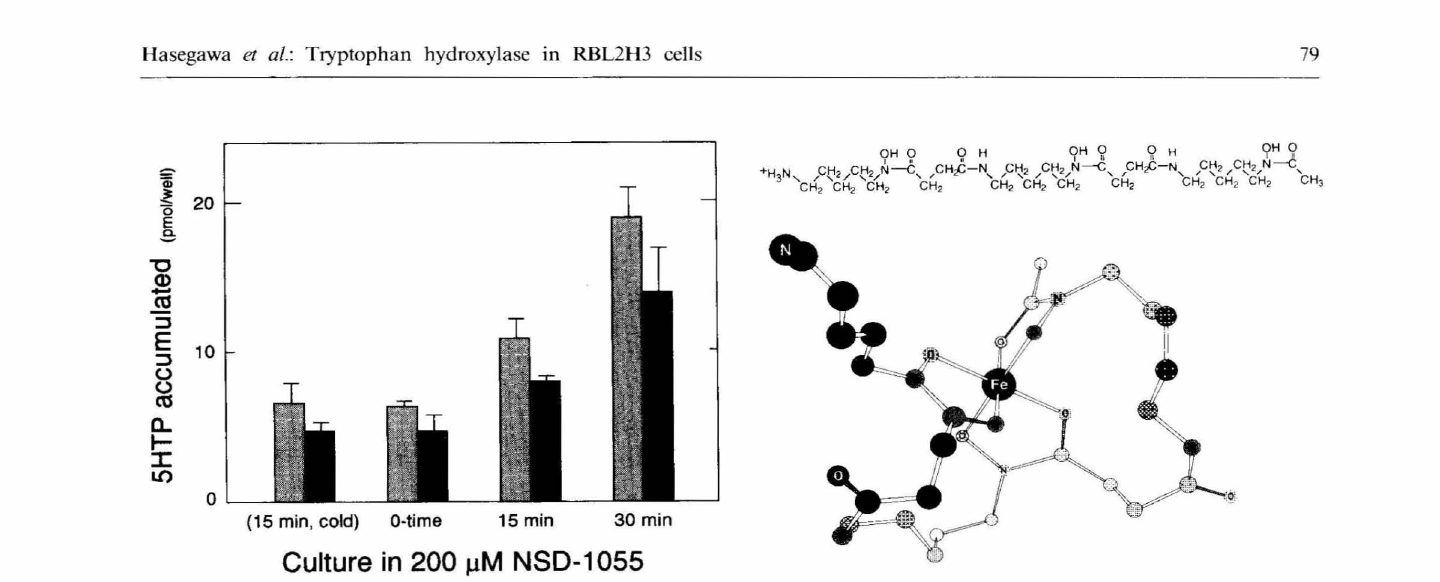
Figure 2. Metabolic accumulation of 5HTP by NSD-1055 in RBL2H3 cells in monolayer culture: RBL2H3 cells were cul tured in serum-free DMEM for 5 h, then replaced with fresh medium with (1m) or without (_) an additional 200 11M tryptophan (basal OMEM contains about 78 f.iM tryptophan).